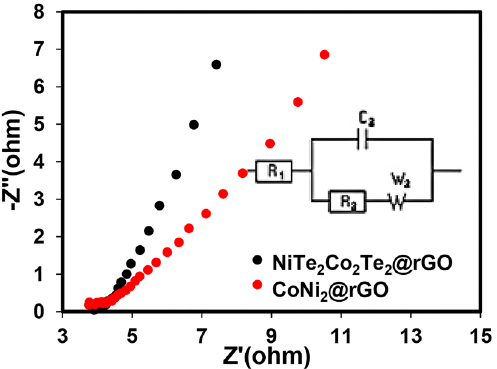
Figure 4. Nyquist plots of the CoNi 2 @rGO and NiTe 2 -Co 2 Te 2 @rGO electrodes from 100 kHz to 100 mHz at open circuit potential (Inset: equivalent circuit).